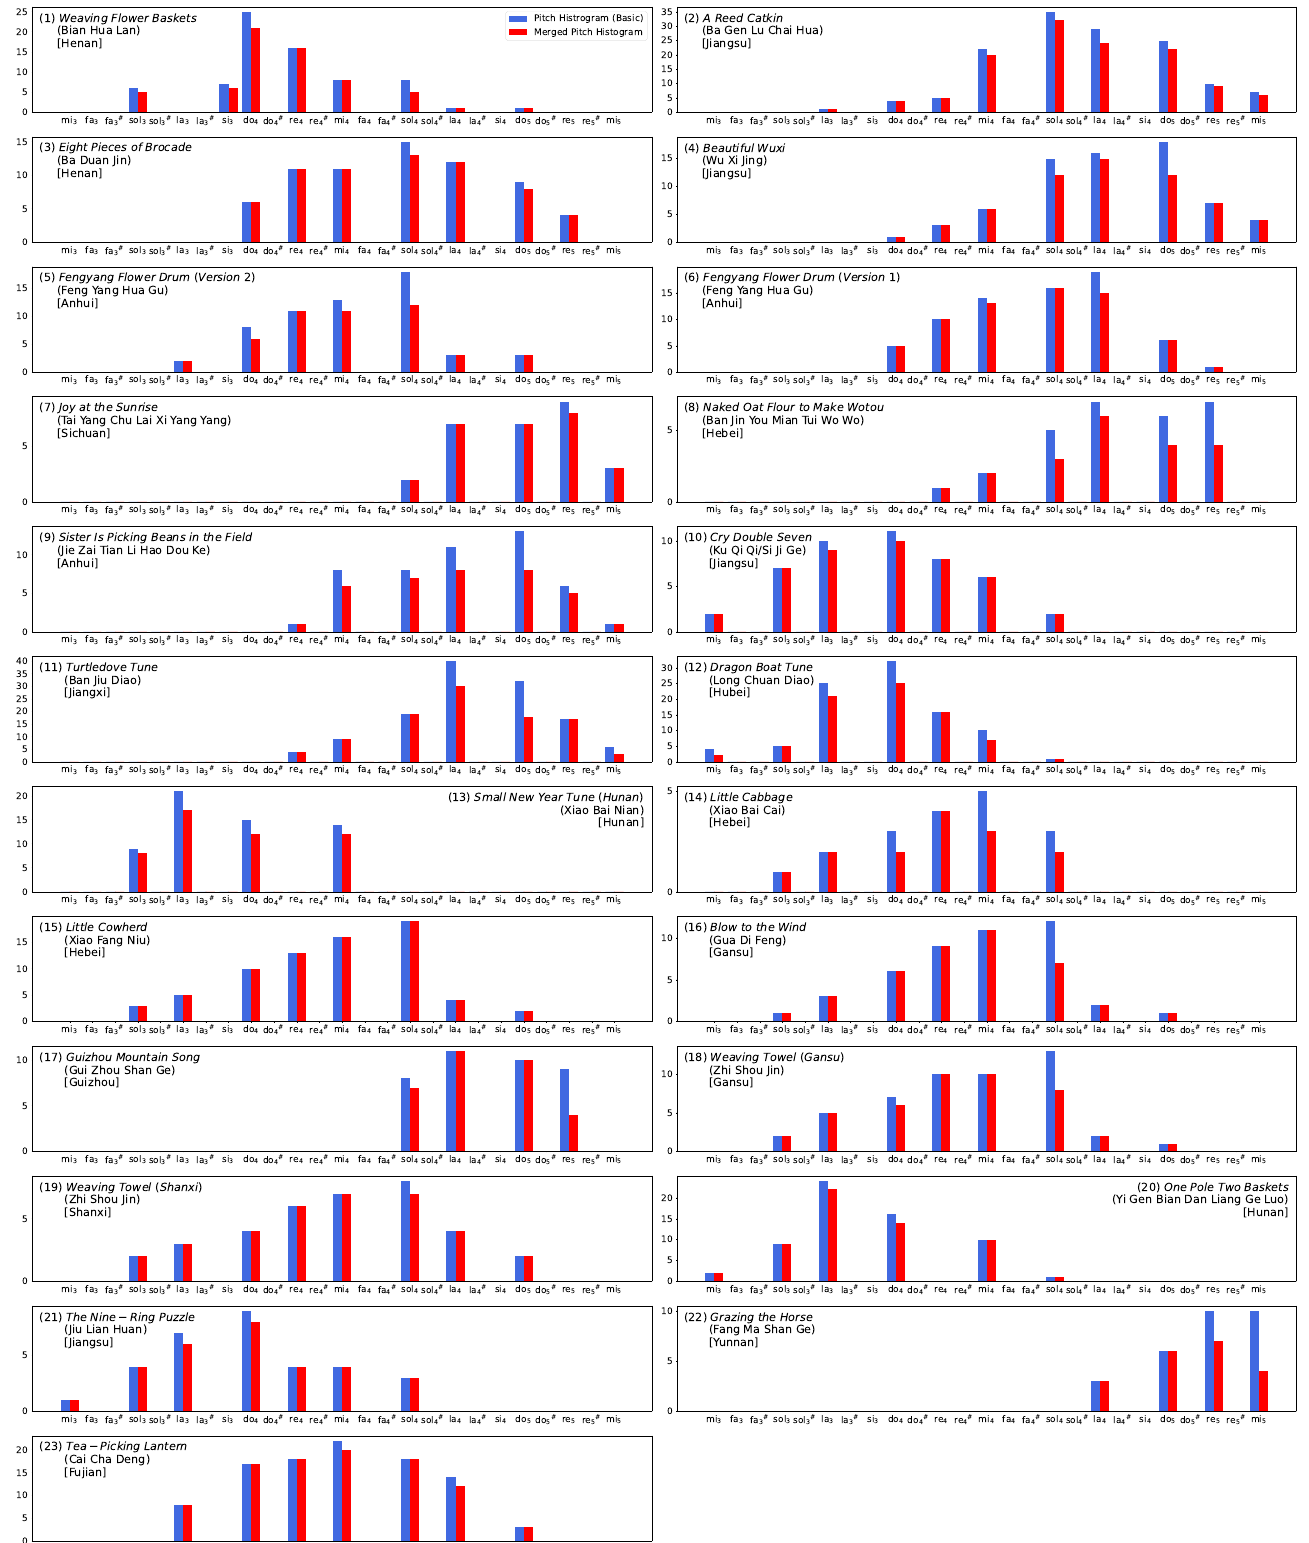
Figure 2. The movable do solfège-based basic pitch histograms and merged pitch histograms for 23 representative traditional Chinese anhemitonic pentatonic folk songs, which naturally conform to the bell shape ( DoBell = 1), with the original names (Hanyu Pinyin) in curved brackets and the provinces of the origin in square